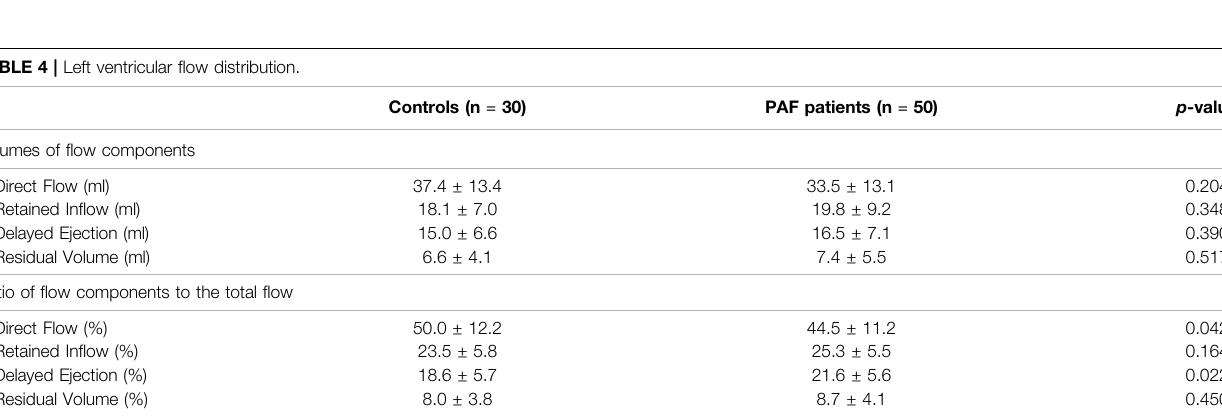
TABLE 4 | Left ventricular fl ow